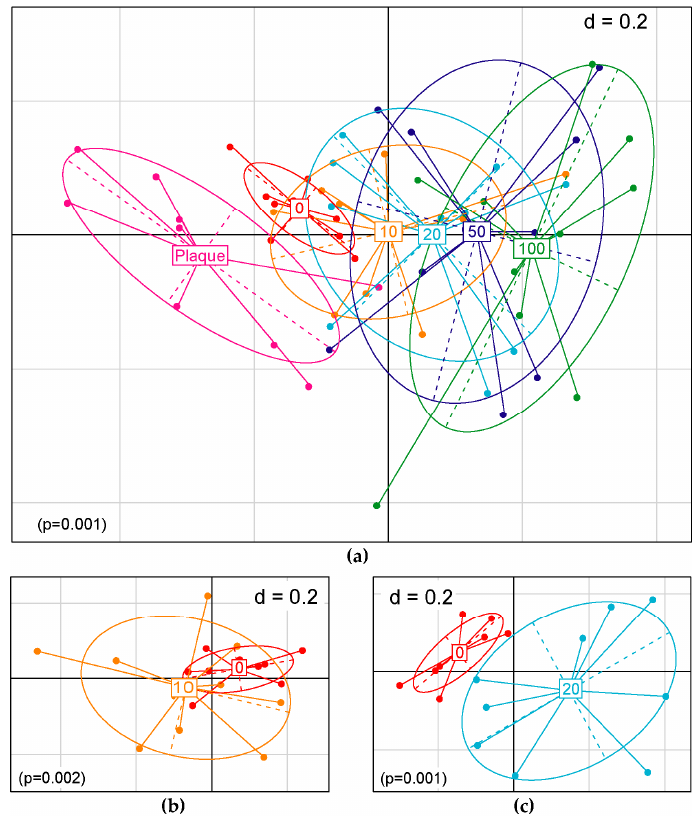
Figure 4. The e ff ect of sodium nitroprusside (SNP) on beta diversity. Overall plaque microbiome composition was depicted by non-metric multidimensional scaling (NMDS) analysis. The plaque samples were treated with NO donor, SNP, at final concentrations in the range of 0–100 mM for 1 h. ( a ) All microbial communities were clustered according to treatment conditions. The relationships between untreated and 10 mM SNP-treated samples ( b ) and untreated and 20 mM SNP-treated samples ( c ) are extracted and depicted. The numbers in the squares indicate the final concentration (mM) of the added SNP. Samples on the first and second principal coordinates are plotted by nodes. Lines connect samples in the same groups, and colored circles cover the samples near the center of gravity for each group.